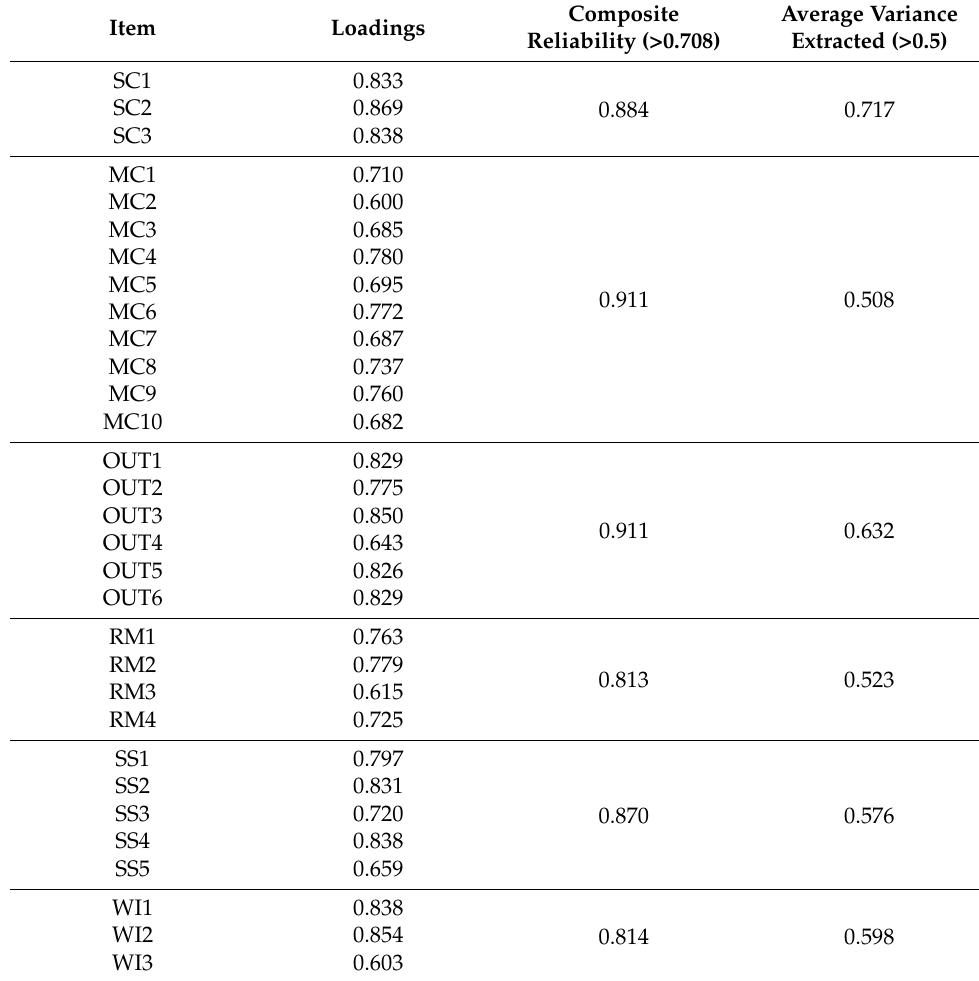
Table 1. Measurement model analysis